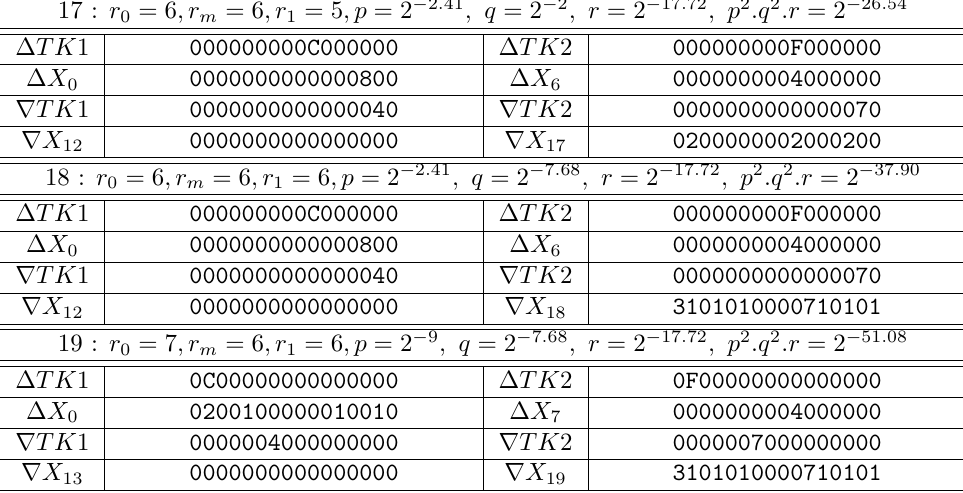
Table 20: Boomerang distinguisher II for 17, 18 and 19 rounds of SKINNY